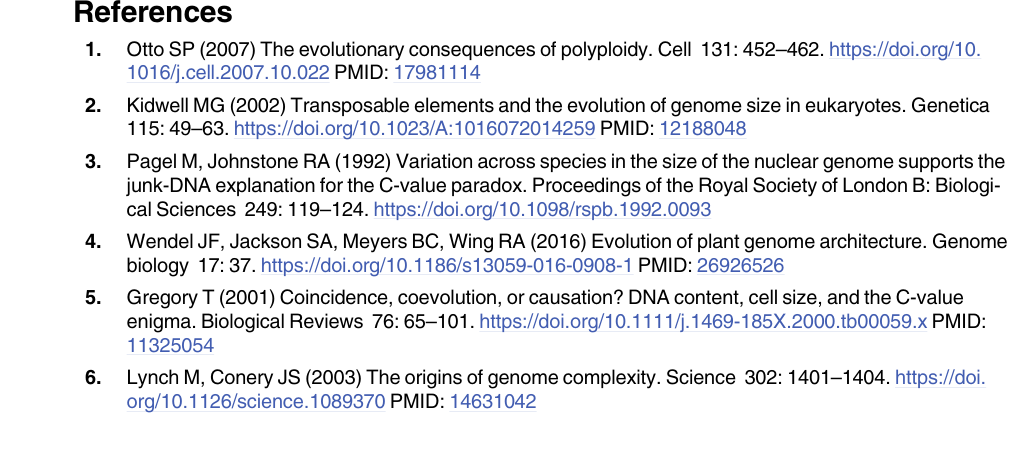
S9 Table. Measured growth rate for Tenango Del Aire population in the growth chamber experiment. In plant ID’s, the first digit indicates the mother, while the second is a unique identifier for each